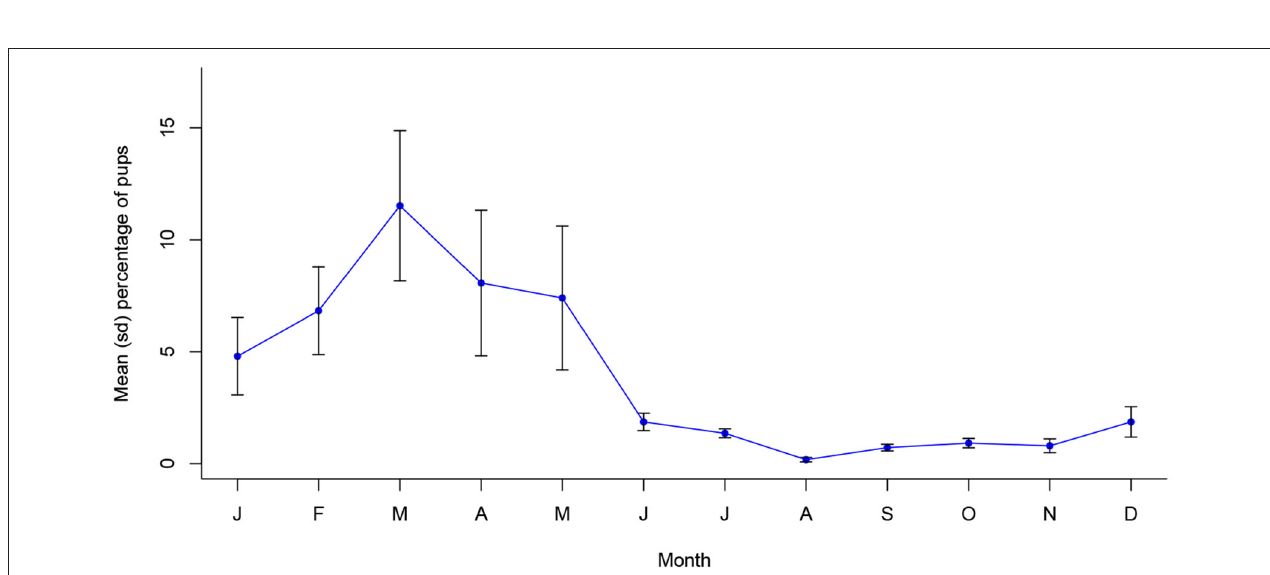
FIGURE 7 | Mean (sd) monthly proportion of pups in Vadodara, India between 2017 and 2021 ( n = 19,978).